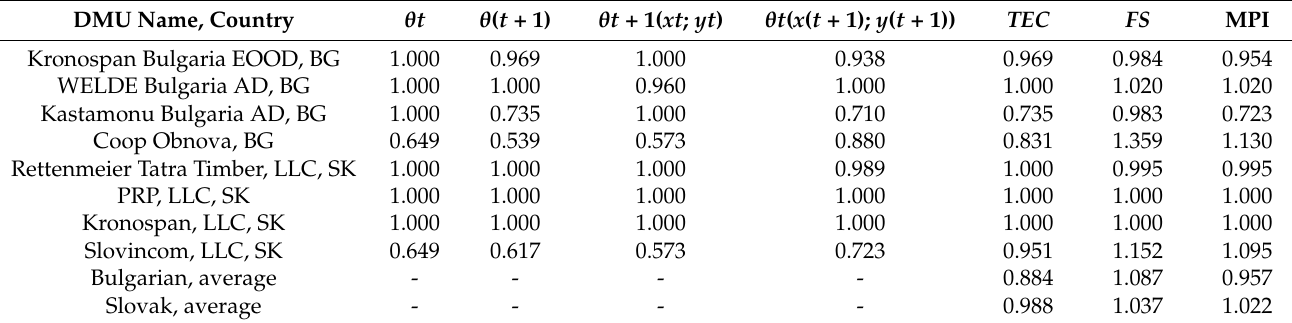
Table 8. MPI results for CCR with labour and depreciations as inputs, t = 2017, t + 1 = 2018. DMU Name,